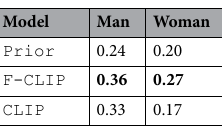
Table 4. F1 macro on STLE ; Prior classifies using empirical class probabilities. Best performing models are in bold.